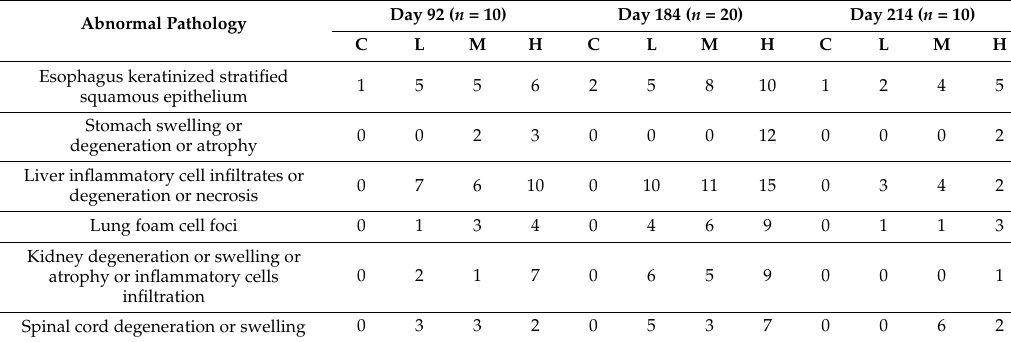
Table 9. Summary of histopathology analyses in